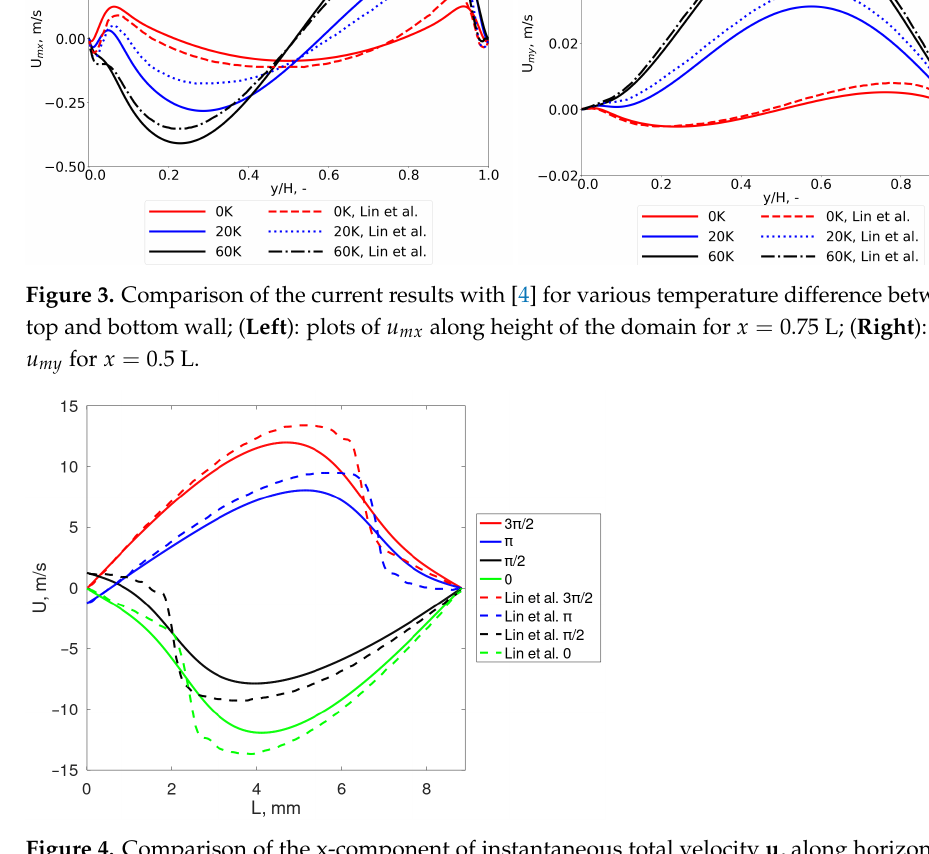
Figure 4. Comparison of the x-component of instantaneous total velocity u , along horizontal mid- plane of the resonator at four different instants: ω t = ( 0, π /2, π ,3/2 π ), obtained in the current study with the results from [4], case